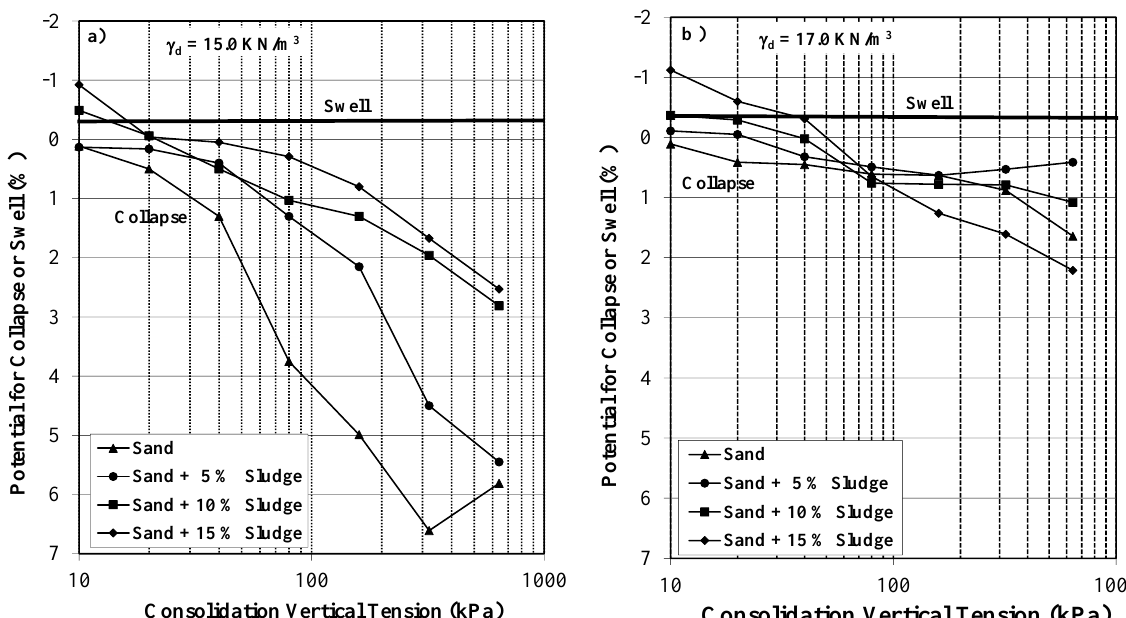
Figure 10. Variation of collapse or expansion potential values with vertical consolidation stress, ( a ) for γ d = 15.0 kN/m 3 and ( b ) for γ d = 17.0 kN/m 3 . Table 4. Collapse potential of simple oedometer tests.